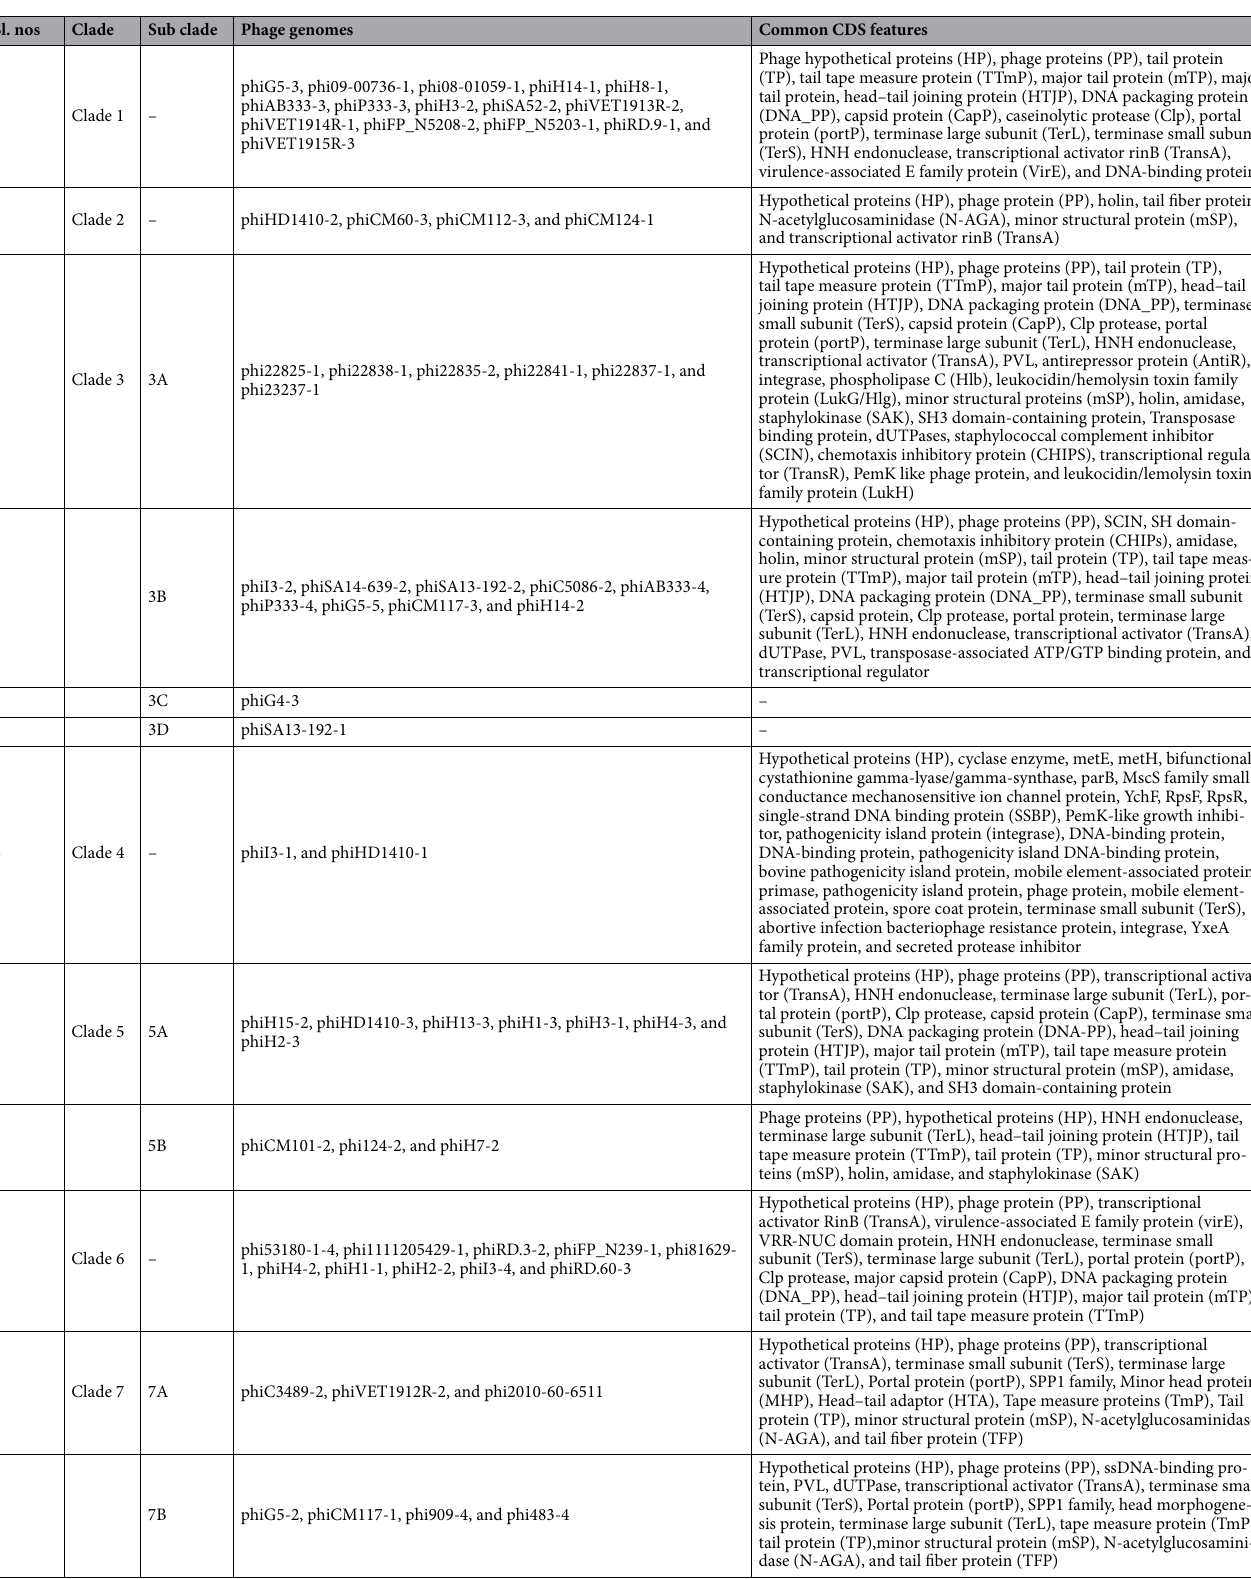
Table 1. Distribution of prophages of S. aureus into different clades obtained from the phylogenetic